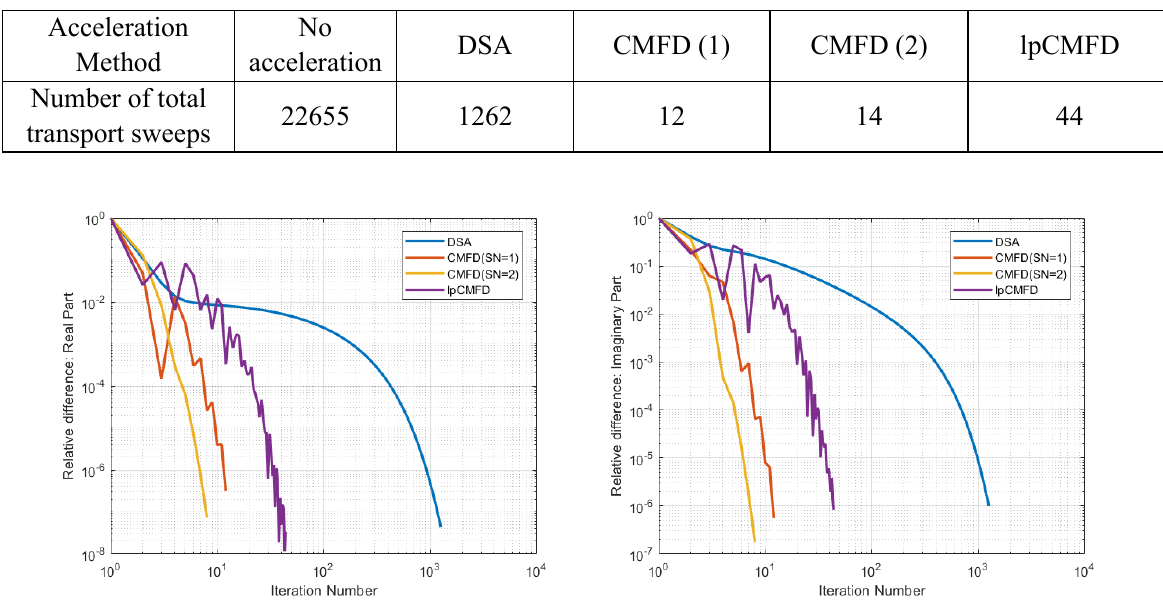
Table I. C4V problem - Acceleration of the dynamic solver with CMFD and DSA methods